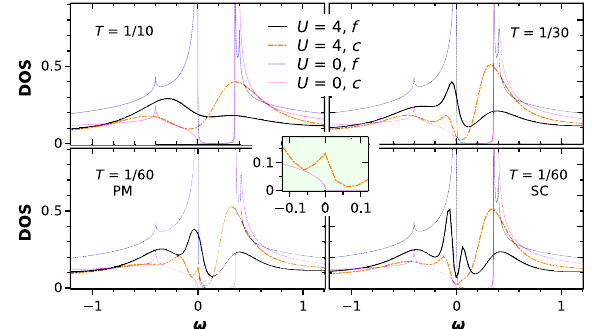
crosshatch.FIG. 3. Local density of states of f and conduction bands at V ¼ 0 . 4 , V 0 ¼ 0 . 8 , and U ¼ 4 for various temperatures. For reference, the DOS for the noninteracting case ( U ¼ 0 ) is repeated on all panels. The bottom left-hand panel shows the DOS when superconductivity is artificially removed. The corre- sponding low-energy conduction band DOS in the underlying normal state is enlarged in the inset. PM and SC in the bottom half of the figure refer respectively to paramagnetic and super- conducting